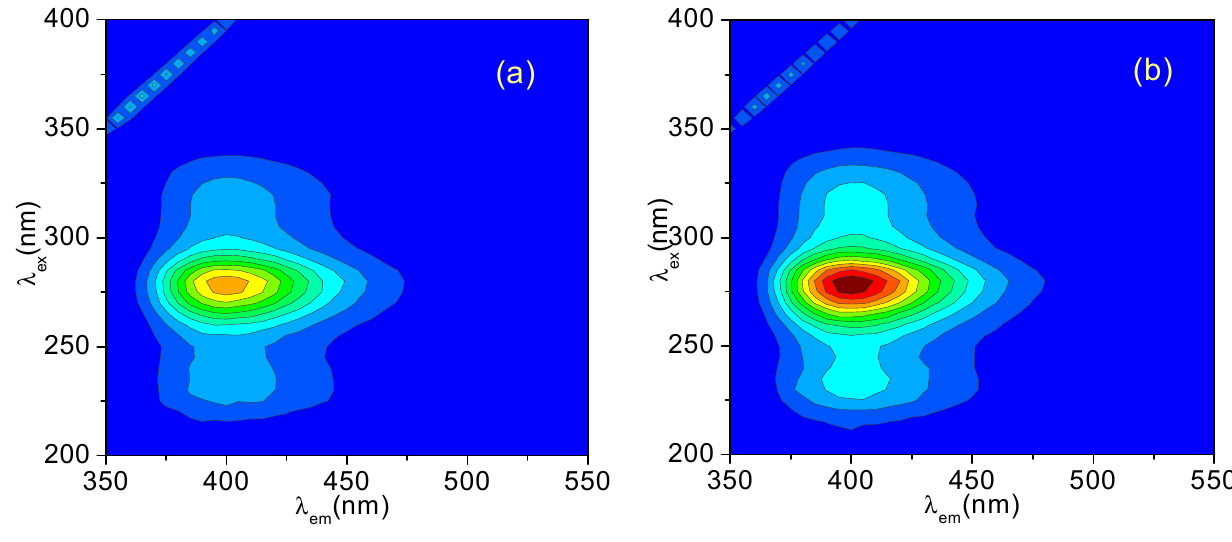
Figure 1 . 3D fluorescence spectra of CH ( a ) and ECH ( b ) in methanol solutions. c CH = 0.133 μ g·mL − 1 , c ECH = 0.181 μ g·mL − 1 , contour interval: 500.